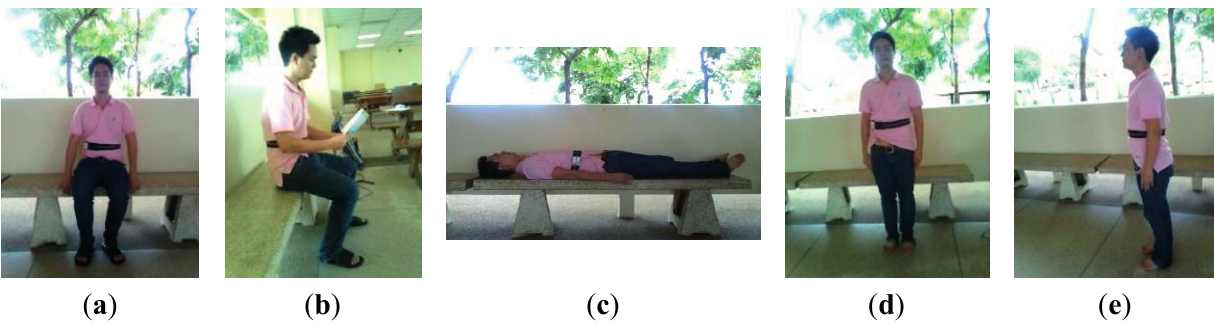
Figure 2. Static activities performed by young subjects (DS2): ( a ) sitting on a chair; ( b ) reading a book; ( c ) lying; ( d ) standing still; and ( e ) deep breathing.